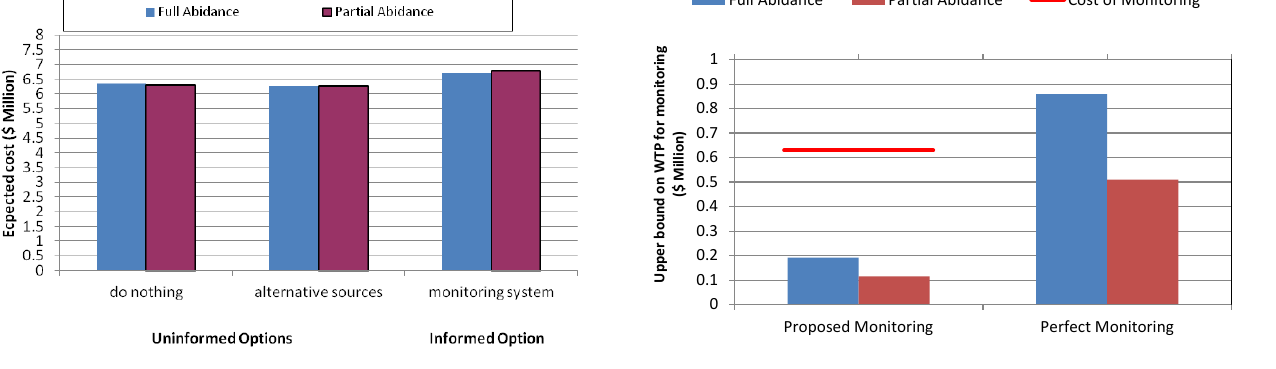
Fig. 6. Upper bounds on willingness-to-pay for monitoring Figure 5. Present-value, expected costs of alternatives. Fig. 5. Present-value expected costs of alternatives. Figure 6. Upper bounds on willingness-to-pay for monitoring systems.